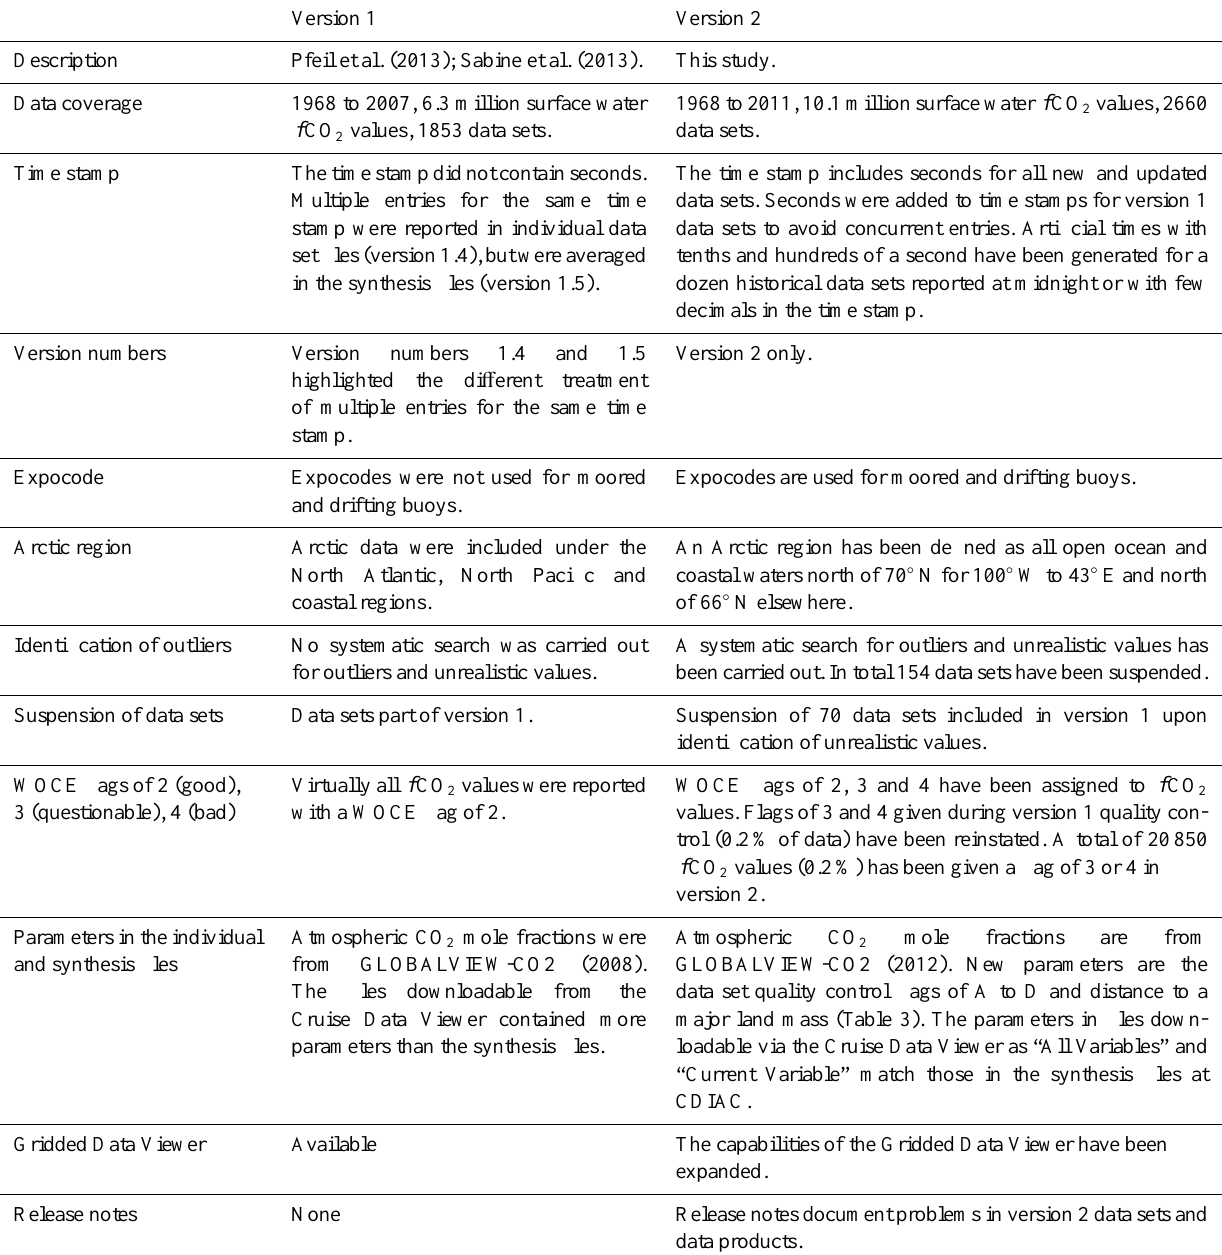
Table 1. Key di ff erences between SOCAT versions 1 (released as versions 1.4 and 1.5) and 2. Further details are in the